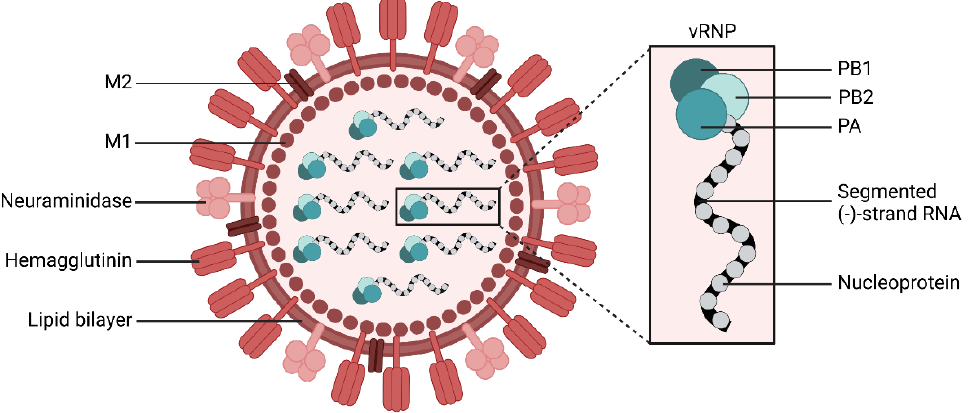
Figure 1. Schematic representation of an influenza A virus. The enveloped virus contains eight single stranded RNA segments encoding for each viral protein and are bound to nucleoproteins. Together with the viral polymerase, they form the viral ribonucleoprotein (vRNP). The viral RNA- dependent RNA polymerase is a heterotrimer consisting of the polymerase acid (PA), polymerase basic 1 (PB1), and polymerase basic 2 protein (PB2). The surface glycoproteins hemagglutinin (HA) and neuraminidase (NA) mediate viral entry and viral release, respectively. The matrix protein (M1) forms a coat inside the virus envelope. The membrane protein (M2) is a proton ion channel, which mediates the acidification of the endosomally entrapped virus. Created with BioRender.com (accessed on 20 September